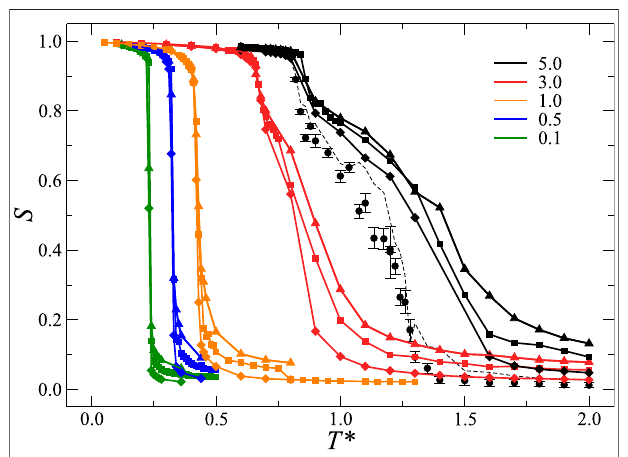
FIGURE 3 | Order parameter S as a function of temperature T p at different pressures P p ∈ [5.0 (black), 3.0 (red), 1.0 (orange), 0.5 (blue), 0.1 (green)] in the bulk 2D system. The response in the order parameter S is compared among different ensemble sizes: N ∈ [500 (triangles), 1,000 (squares), 4,000 (diamonds)]. Finite-size effects become pronounced as pressureincreases(andcorrespondingly athighertemperature).For P p (cid:2) 5 . 0, results are also included for N ∈ [10,000 (dashed line), 50,000 (circles with error bars)]. Finite-size effects appear to dissipate when N is of O ( 10 4 )